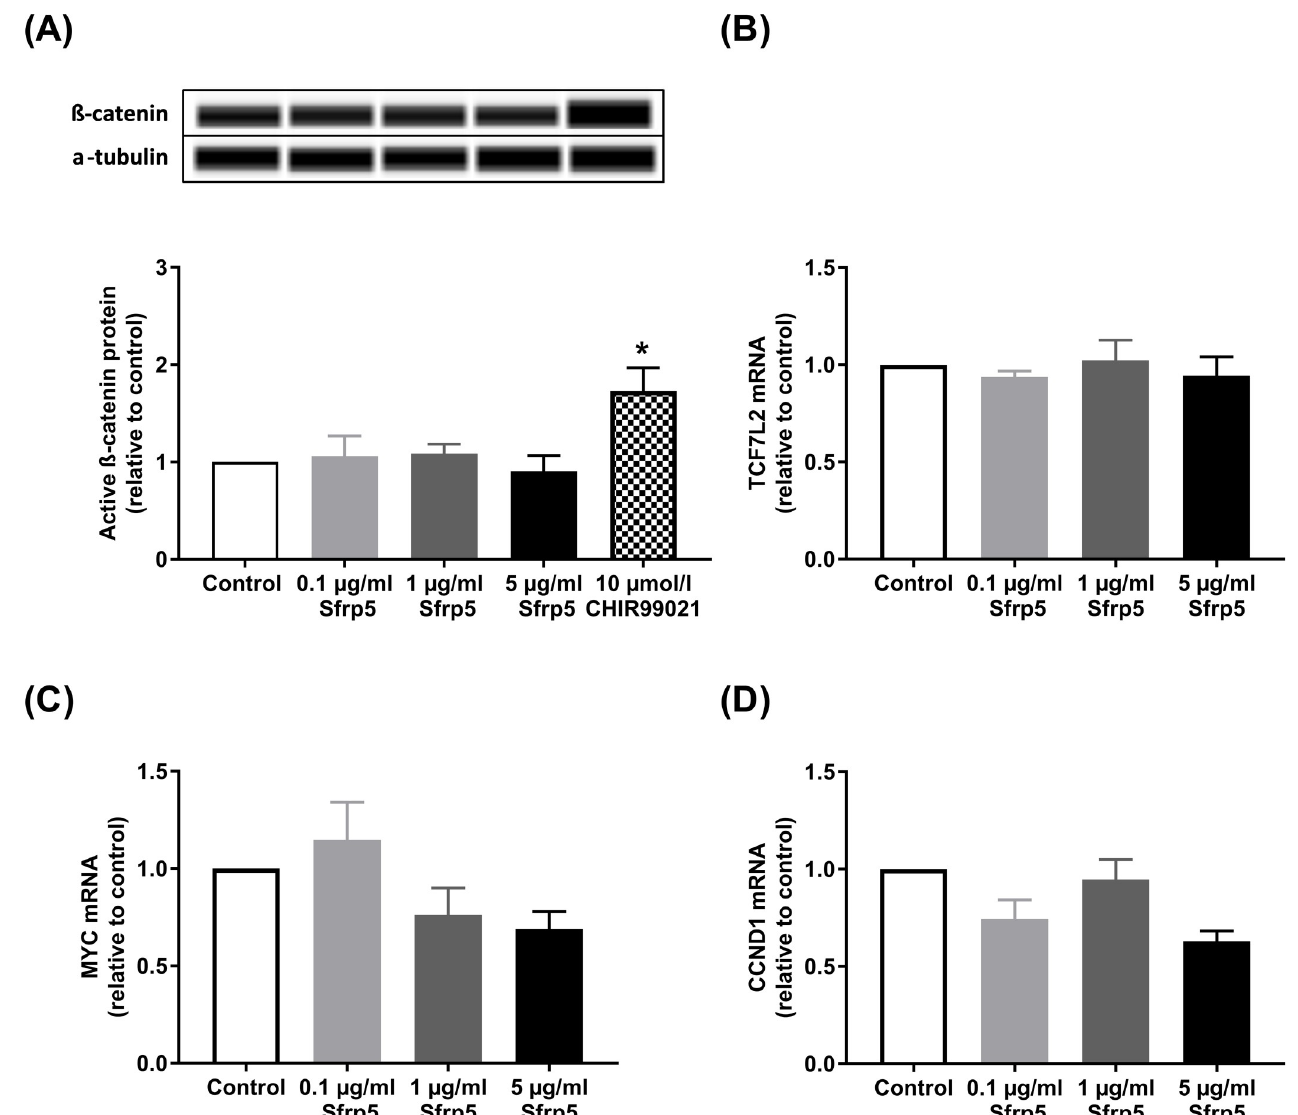
Fig 3. Sfrp5 and canonical Wnt signalling. Effect of different concentrations of Sfrp5 on markers and target genes of the canonical Wnt-signalling pathway: (A) protein levels of the active form of the non-phospho β -catenin (92 kDa) (N = 5), (B) mRNA levels of the transcription factor 7-like 2 (TCF7L2) (N = 4), (C) mRNA levels of MYC (N = 4) and (D) mRNA levels of CCND1 (N = 4) (normalised to eukaryotic initiation factor 4A-II (EIF4A2)) in INS-1E cells. The loading control for the Western blot was α -tubulin (52 kDa). CHIR99021 is a positive regulator of the canonical Wnt-signalling pathway. Data are presented as mean + SEM (fold change relative to control). � , p < 0.05 vs.